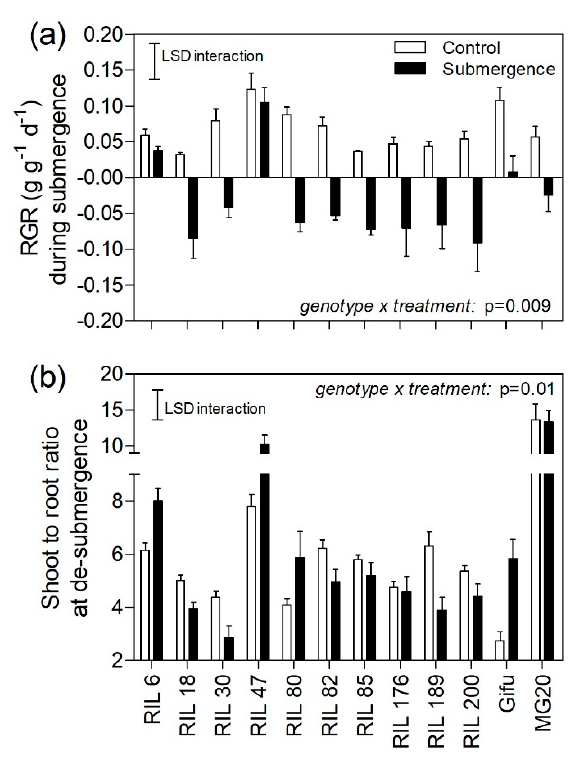
Figure 1. ( a ) Plant relative growth rate (RGR, g g-1 d-1) of 12 genotypes of Lotus japonicus (10 recombinant inbred lines and their parents Gifu and MG20) subjected to control and submergence in clear water for one week. ( b ) Shoot to root dry mass ratio (S:R) after the first week of the experiment both at control and de-submergence. The least significative difference (LSD) for the genotype × treatment interaction is shown in (a) (LSD RGR = 0.065) and (b) (LSD S:R = 3.7). Values are means ± standard errors of 6–8